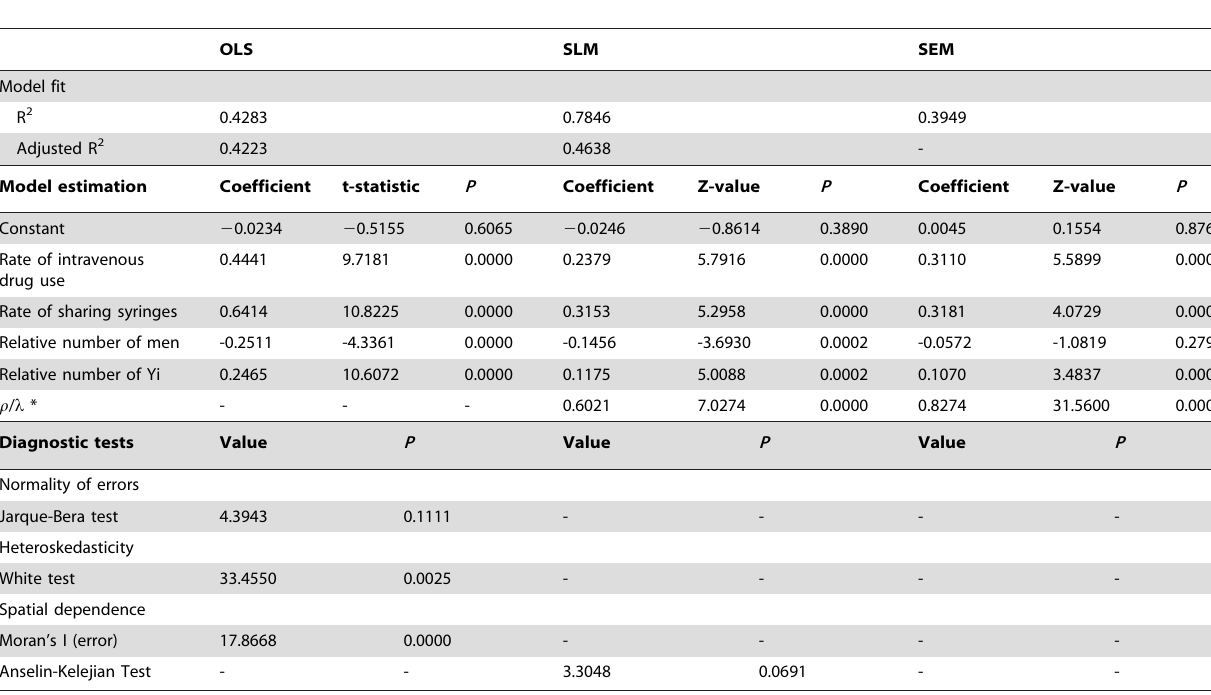
Table 3. Association of the prevalence of HIV/HCV co-infection and risk